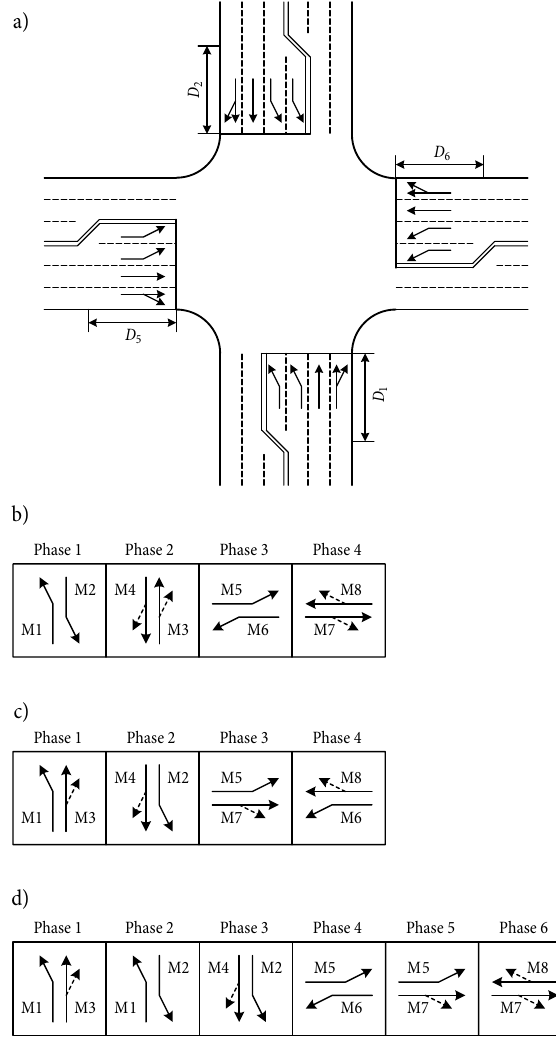
Fig. 5. Channelization scheme and signal phase plans for a four-leg intersection: a – channelization scheme; b – exclusive left-turn phasing; c – left-through phasing; d – overlapping